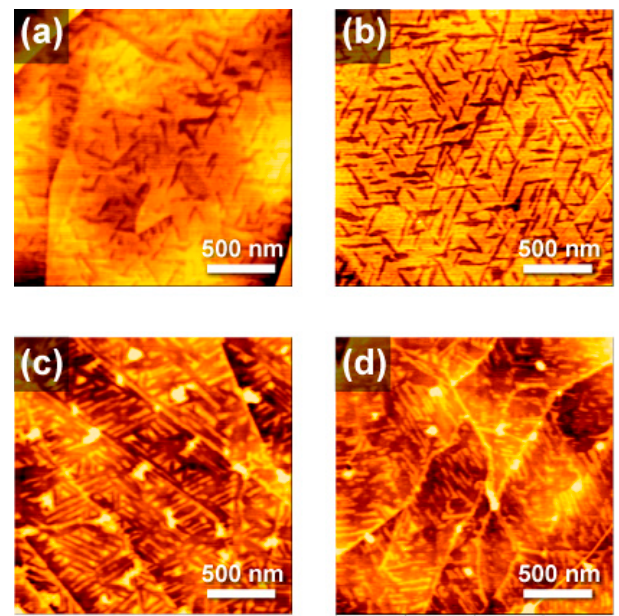
Figure 3. AFM topographic images of the SAM of 1 on highly oriented pyrolytic graphite (HOPG). The fabrication was carried out through dip-coating in a benzene solution of 1 (1 µmol L − 1 ) in the absence ( a ) and presence of naphtalene ( b – d ). The concentration of naphtalene was 50 µmol L − 1 ( b ), 100 µmol L − 1 ( c ) and 200 µmol L − 1 ( d ).